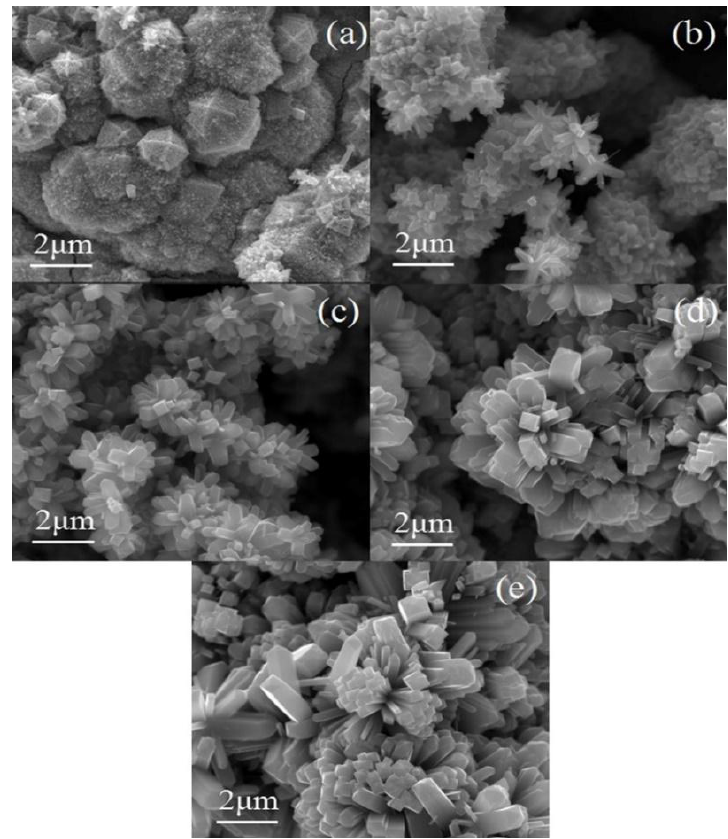
Figure 8. SEM images with different temperature. ( a ) 180 °C; ( b ) 200 °C; ( c ) 220 °C; ( d ) 240 °C; ( e ) 260 °C.